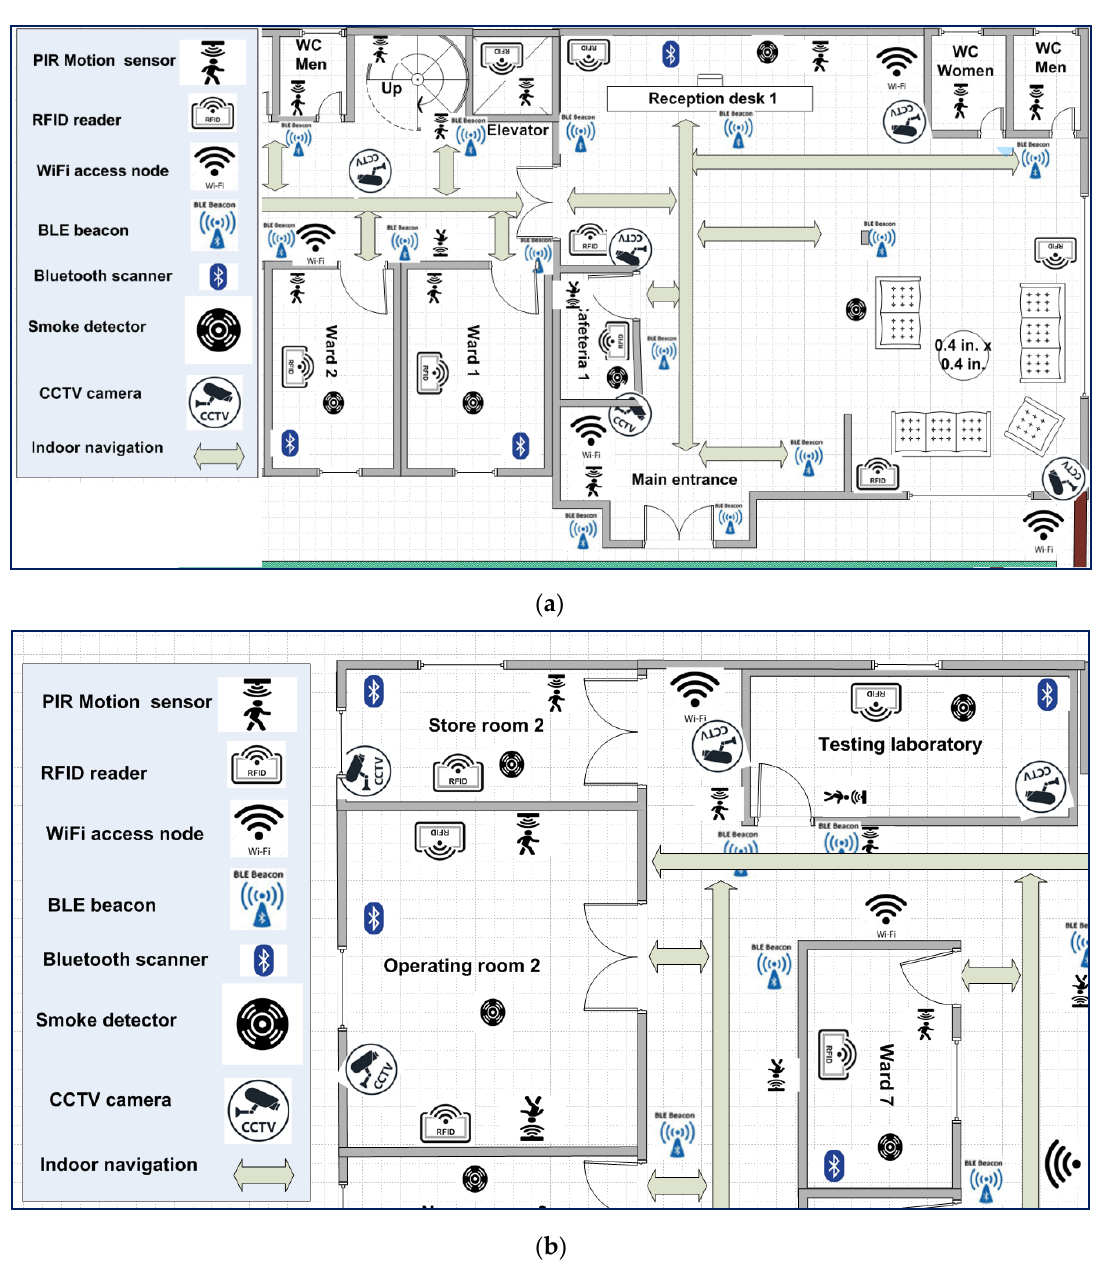
Figure 5. ( a ) One typical SETs deployment scenario on the first floor of the hospital. ( b ) One typical SETs deployment scenario on the second floor of the hospital. Table 8. The cost implication of SETs deployment scenario.